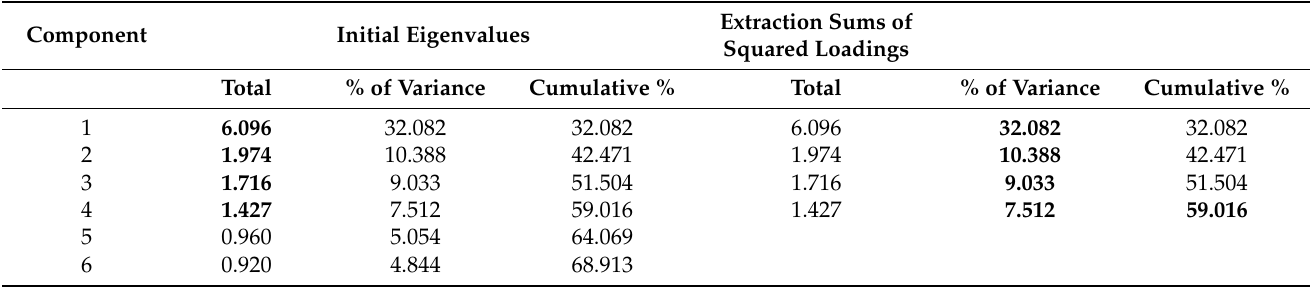
Table 8. Total Variance